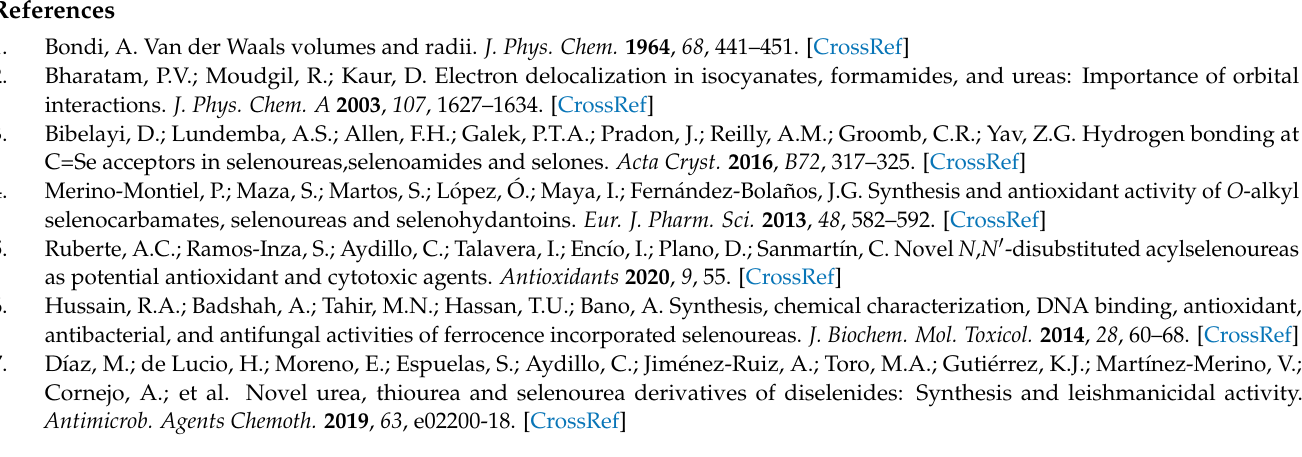
Figure S14. IR spectra of N -[4-fluorophenyl]- N (cid:48) -[(8 R ,9 R )-10,11-dihydro-6 (cid:48) -methoxycinchonan-9- yl]selenourea e DHQD-7g, Figure S15. 1H and 13C NMR spectra of N -[(8 S ,9 S )-6 (cid:48) -methoxycinchonan- Figure S17. 1H NMR spectra of N,N (cid:48) -bis[(8 S ,9 S )-6 (cid:48) -metoxycinchonan-9-yl]selenourea 10a, Figure S18. IR spectra of N,N (cid:48) -bis[(8 S ,9 S )-6 (cid:48) - metoxycinchonan-9-yl]selenourea 10a, Figure S19. 1H and 13C NMR spectra of N -[4-fluorophenyl]- N (cid:48) -[(8 S ,9 S )-6 (cid:48) -methoxycinchonan-9-yl]thiourea e QN-12a, Figure S20. IR spectra of N -[4-fluorophenyl]- N (cid:48) -[(8 S ,9 S )-6 (cid:48) -methoxycinchonan-9-yl]thiourea e QN-12a, Figure S21. HPLC chromatogram for 14: sample obtained with catalyst e QN-7a, Figure S22. HPLC chromatogram for 14: sample obtained with catalyst e QN-7b, Figure S23. HPLC chromatogram for 14: sample obtained with catalyst e QN-7c, Figure S24. HPLC chromatogram for 14: sample obtained with catalyst e CD-7d, Figure S25. HPLC chromatogram for 14: sample obtained with catalyst e DHQN-7e, Figure S26. HPLC chromatogram for 14: sample obtained with catalyst e QD-7f, Figure S27. HPLC chromatogram for 14: sample obtained with catalyst e DHQD-7g, Figure S28. HPLC chromatogram for 14: sample obtained with catalyst e QN-12a, Figure S29. HPLC chromatogram for racemic 14 without catalyst 7, Figure S30. HPLC chromatogram for 15: sample obtained with catalyst e QN-7a, Figure S31. HPLC chromatogram for 15: sample obtained with catalyst e QN-7b, Figure S32. HPLC chromatogram for 15: sample obtained with catalyst e QN-7c, Figure S33. HPLC chromatogram for 15: sample obtained with catalyst e CD-7d, Figure S34. HPLC chromatogram for 15: sample obtained with catalyst e DHQN-7e, Figure S35. HPLC chromatogram for 15: sample obtained with catalyst e QD-7f, Figure S36. HPLC chromatogram for 15: sample obtained with catalyst e DHQD-7g, Figure S37. HPLC chromatogram for 15: sample obtained with catalyst e QN-12a, Figure S38. HPLC chromatogram for racemic 15 without catalyst